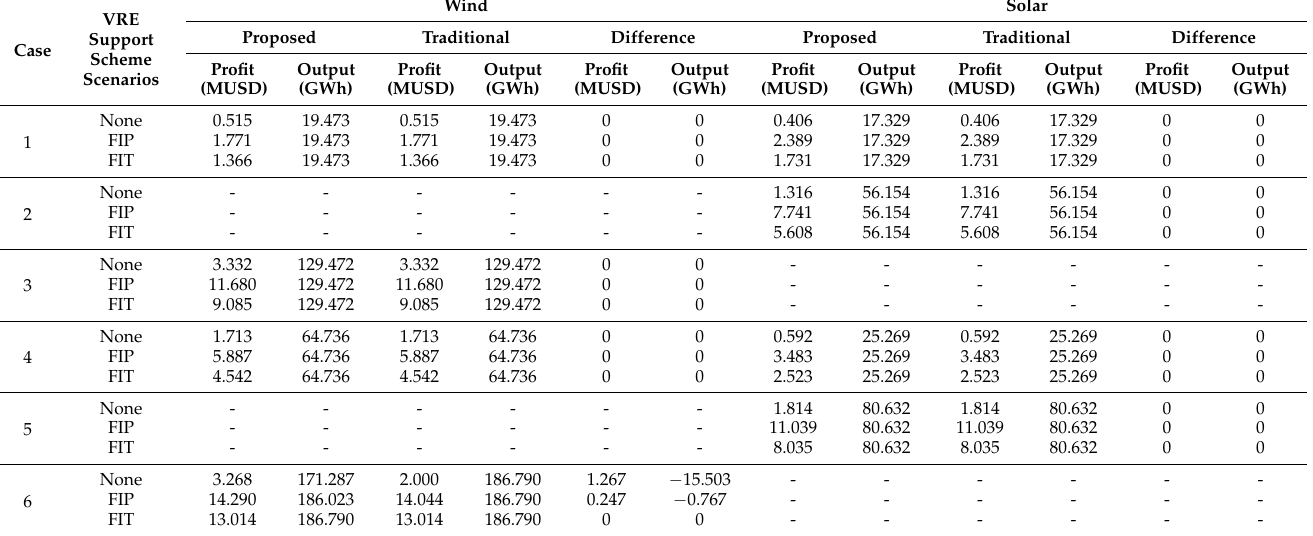
Table 4. The VRE generators’ daily profits and the output during a